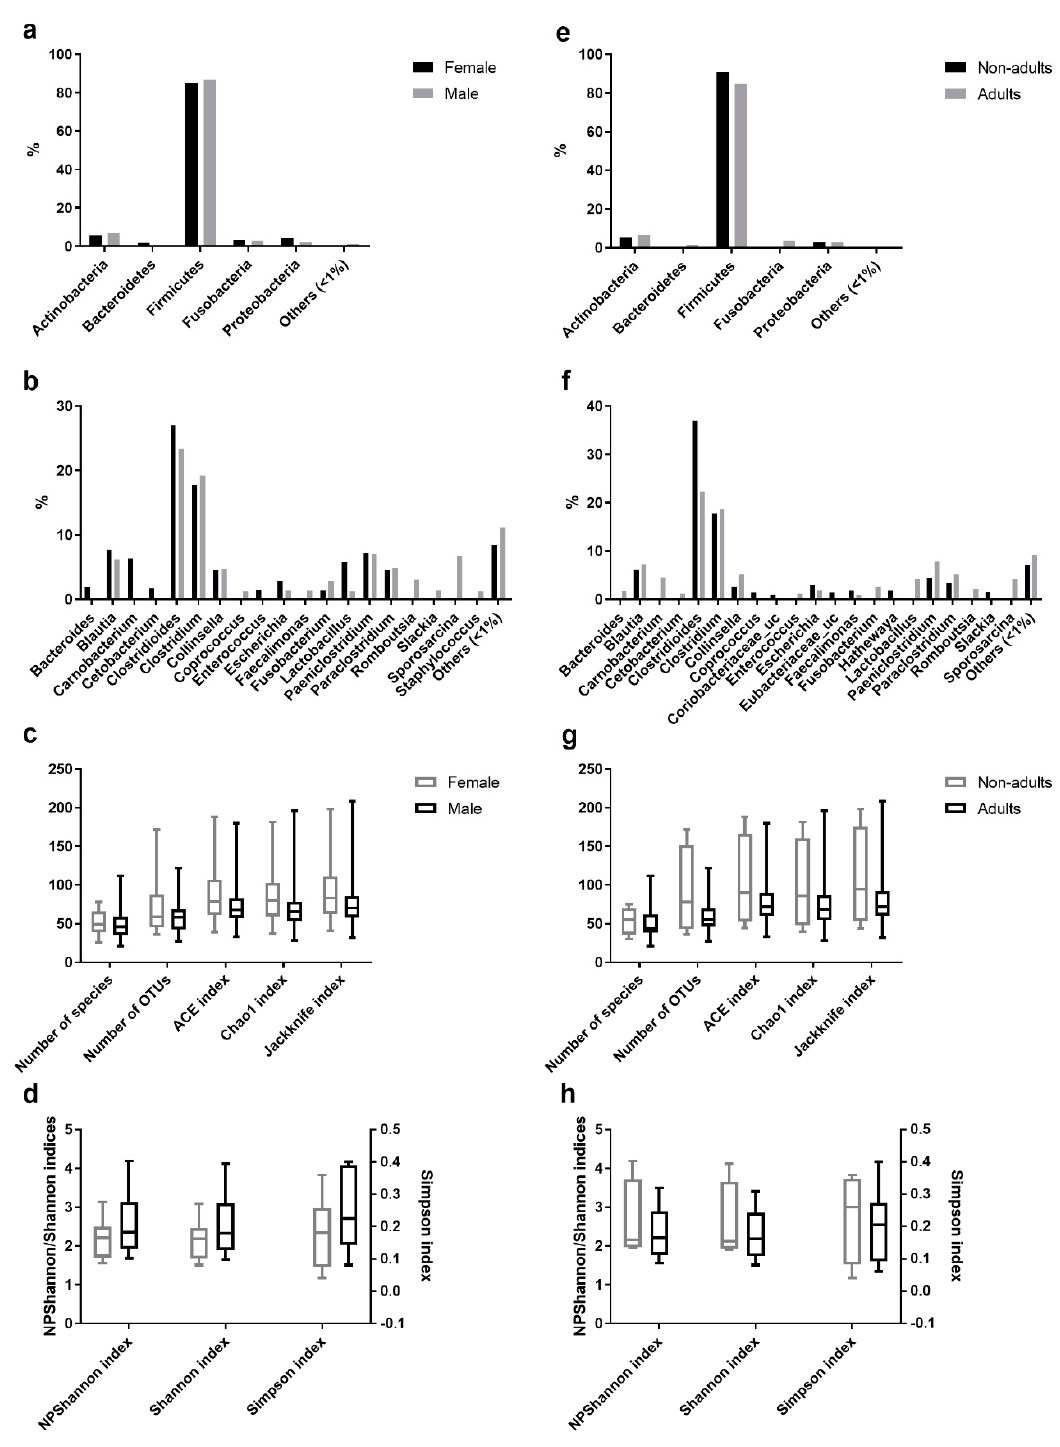
Figure 3. Comparison of the intestinal bacterial microbiota of the Egyptian mongoose between sex and age class. ( a ) Relative abundance on a phylum and ( b ) genus level of female and male individuals. ( c ) Species richness (number of species, number of OTUs, ACE, Chao1, and Jackknife indices) and ( d ) species evenness (NPShannon, Shannon, and Simpson indices) of female and male individuals. ( e ) Relative abundance on a phylum and ( f ) genus level of adult and non-adult individuals. ( g ) Species richness (number of species, number of OTUs, ACE, Chao1, and Jackknife indices) and ( h ) species evenness (NPShannon, Shannon, and Simpson indices) of adult and non-adult individuals.